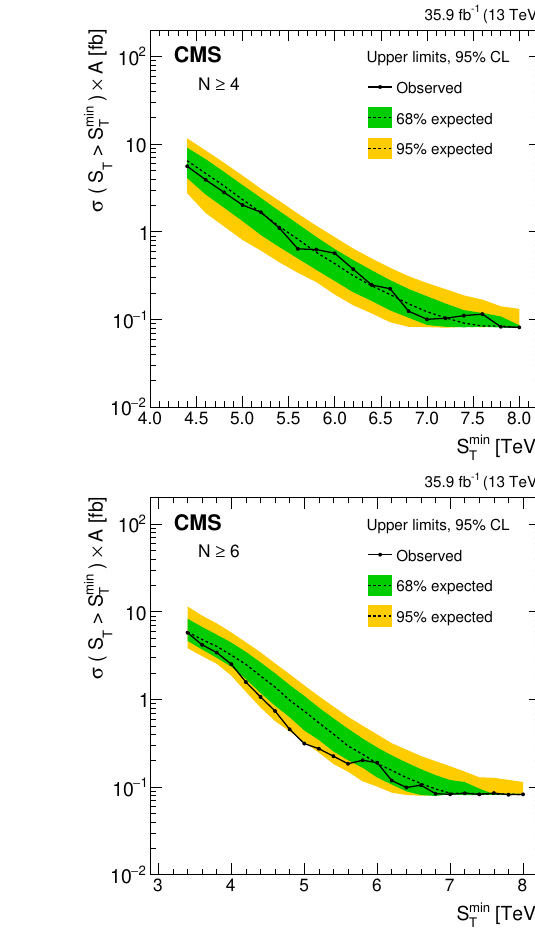
Figure 6 . Model-independent upper limits on the cross section times acceptance for four sets of inclusive multiplicity thresholds, N (cid:21) 3 ; : : : ; 6 (left to right, upper to lower). Observed (expected) limits are shown as the black solid (dotted) lines. The inner (outer) band represents the (cid:6) 1 ( (cid:6) 2) standard deviation uncertainty in the expected